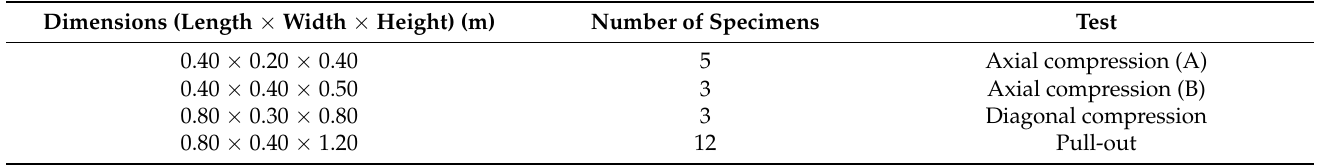
Table 2. Dimensions and number of walls built for experimental